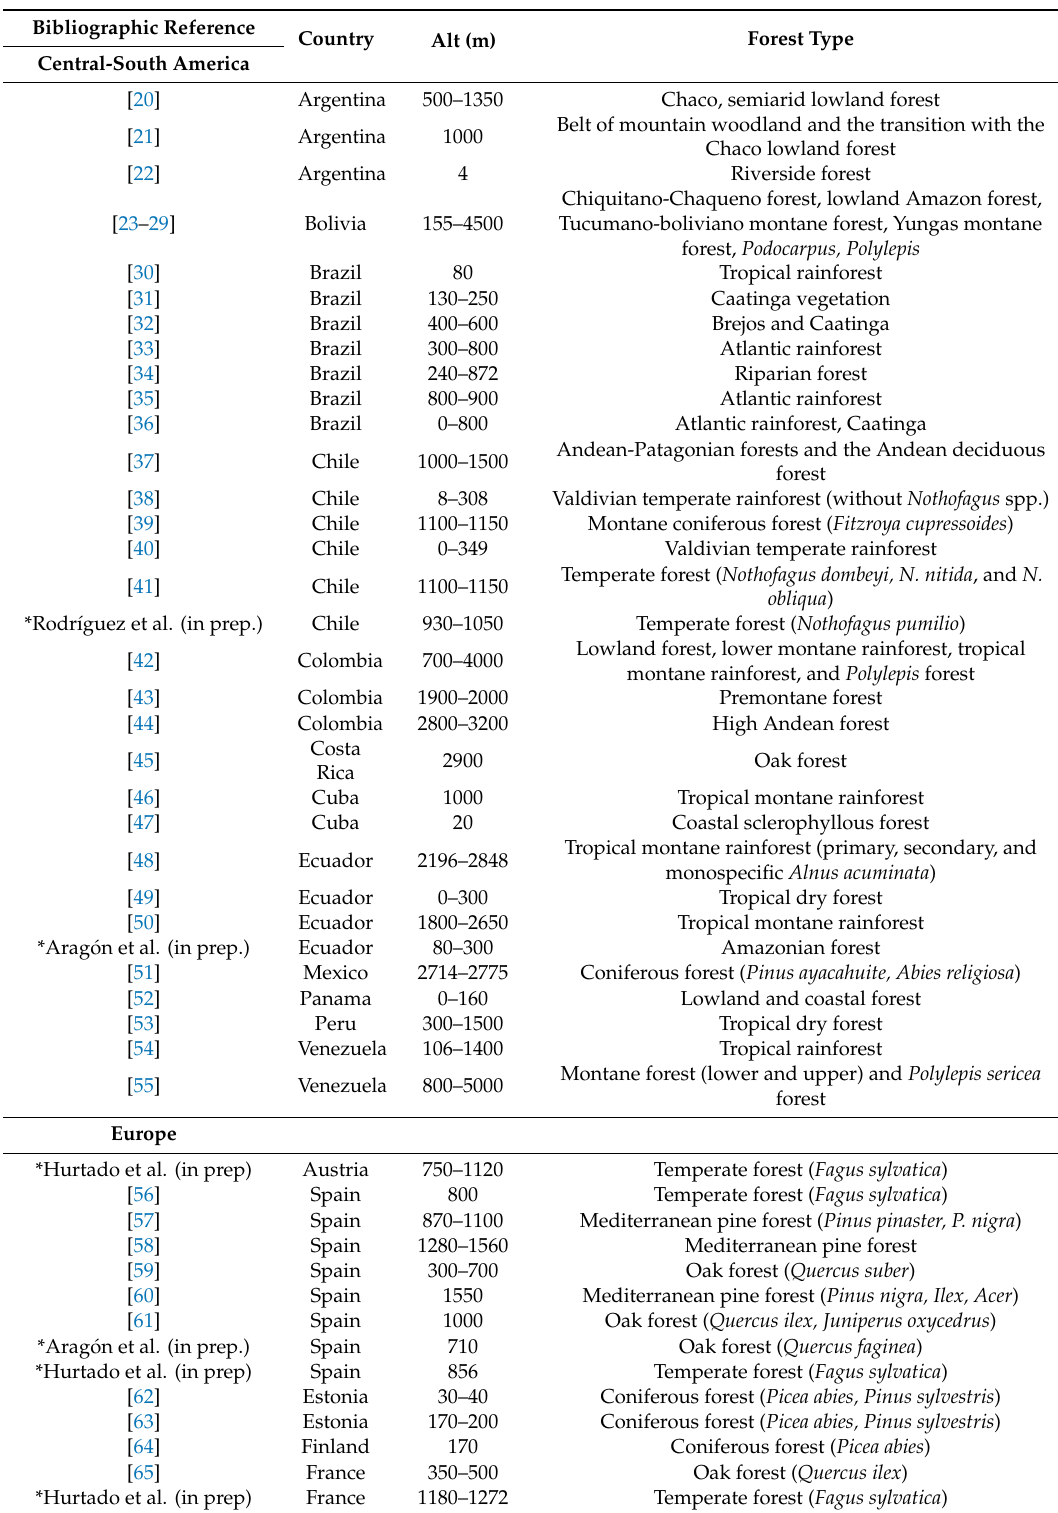
Table 1. Summary of the reviewed studies according to the country (in alphabetical order). Altitude (Alt) and forest type are also included. * refers to four ecological unpublished studies from our own research